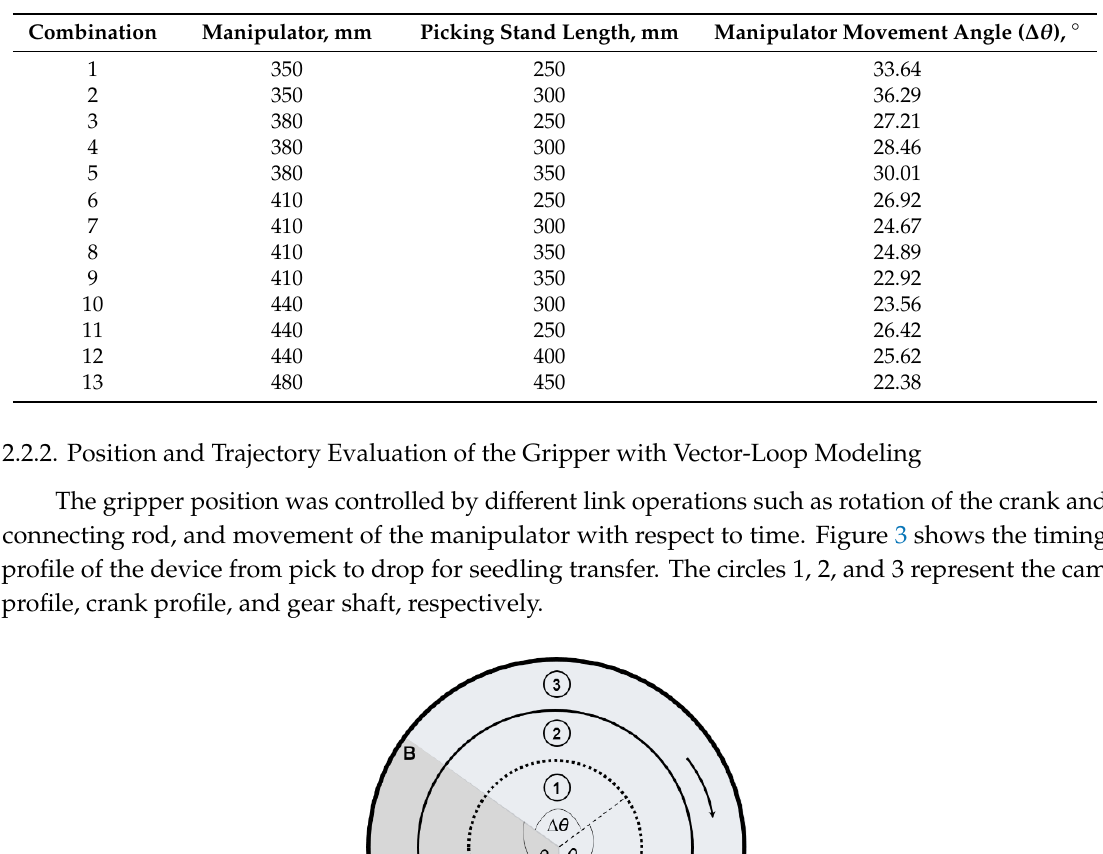
Table 2. Selected feasible length combinations of picking stand and manipulation.